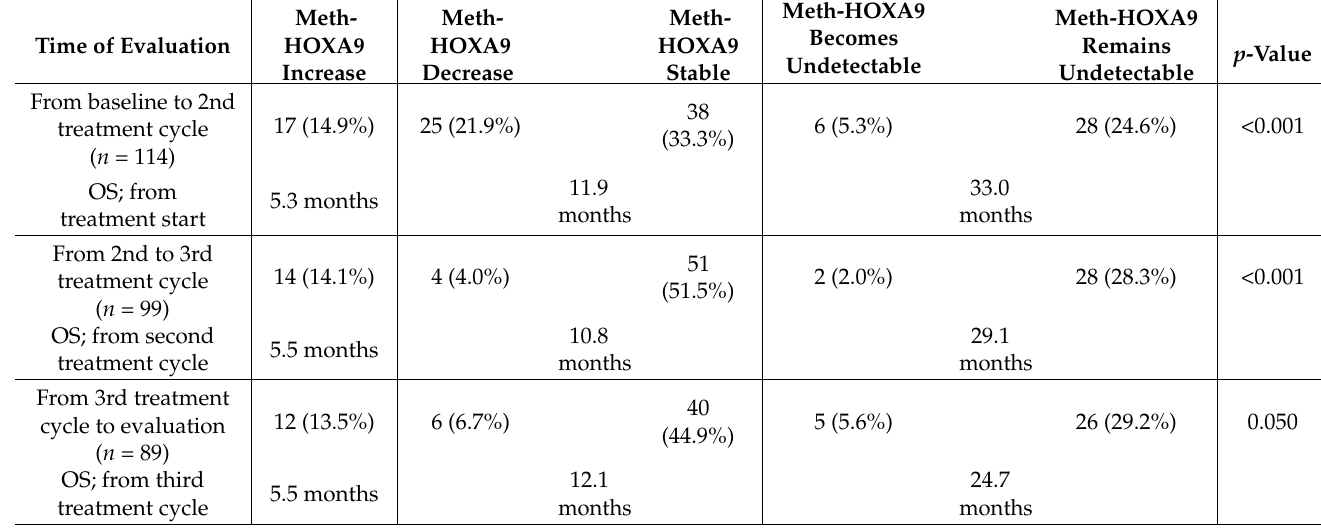
Table 3. Dynamics of meth- HOXA9 during treatment and the correlation with overall survival.